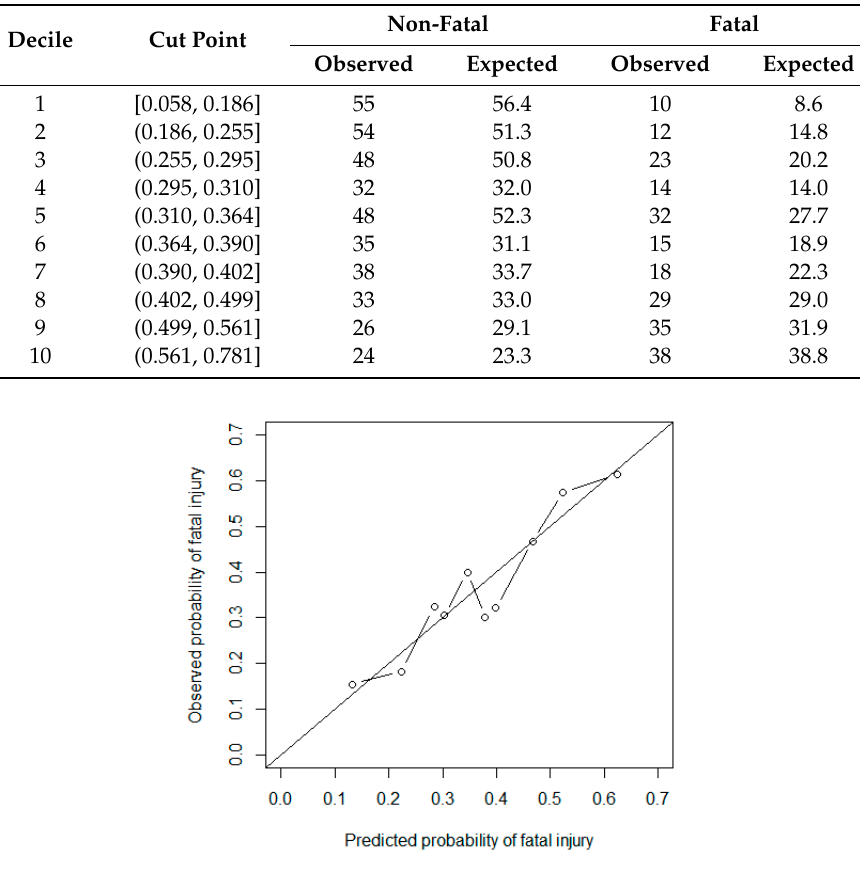
Figure 2. Observed and predicted probabilities of fatal injury in ten deciles of risk.